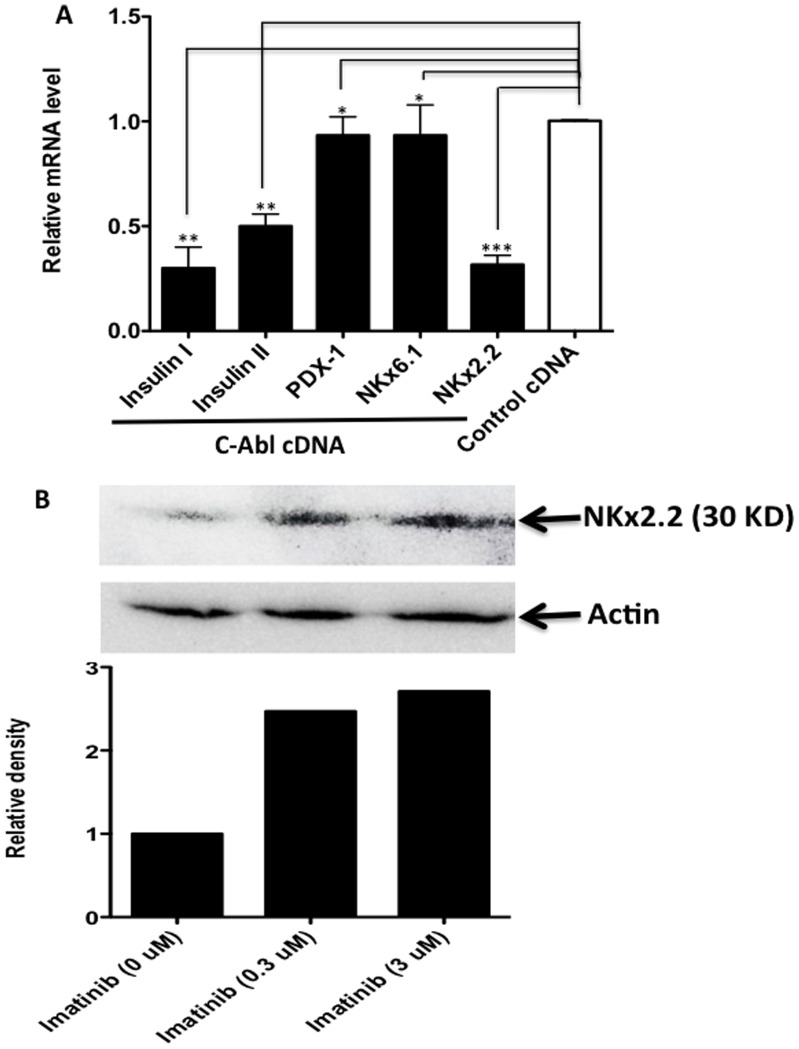
C-Abl regulates insulin gene expression via NKx2.2.
A. NIT-1 cells were tranduced with retrovirus vector encoding c-Abl gene to overexpress c-Abl or control cDNA. Twenty-four hrs later, the cells were examined for the gene expression of insulin, PDX-1, NKx6.1, NKx2.2, respectively by real-time RT-PCR. The PCR results were normalized relative to β actin for each individual gene, and the relative values of c-Abl transduced cells were compared to those of control cDNA transduced cells which were defined as 1 (the white bar). The results shown were from a representative of 3 independent experiments. One-way ANOVA with post hoc test was performed. *: p>0.05, **:p<0.01, ***:p<0.001. B. NIT-1 cells were cultured in the low glucose DMEM medium alone (Immatinib 0 µM), or in the presence of 0.3 µM Imatinib, or 3 µM Imatinib (3 µM) for 24 hrs. The protein levels of NKx2.2 were examined by Western blot. The densitometry was analyzed relative to the levels of β-actin, and the relative level of the cells incubated with 0 µM Imatinib was defined as 1.